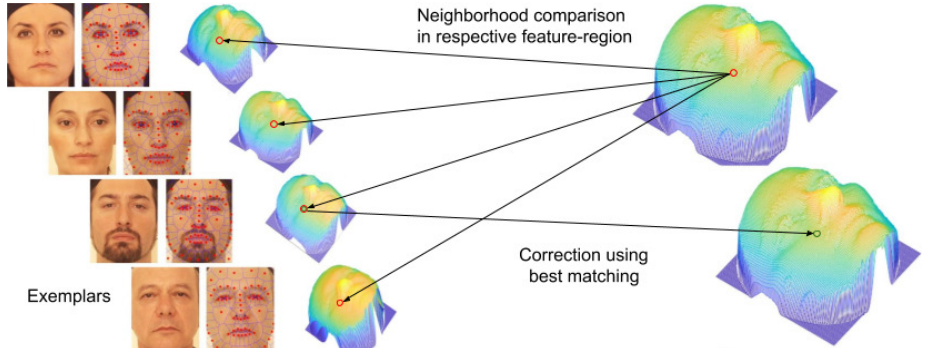
Figure 7. The pipeline of the filtering